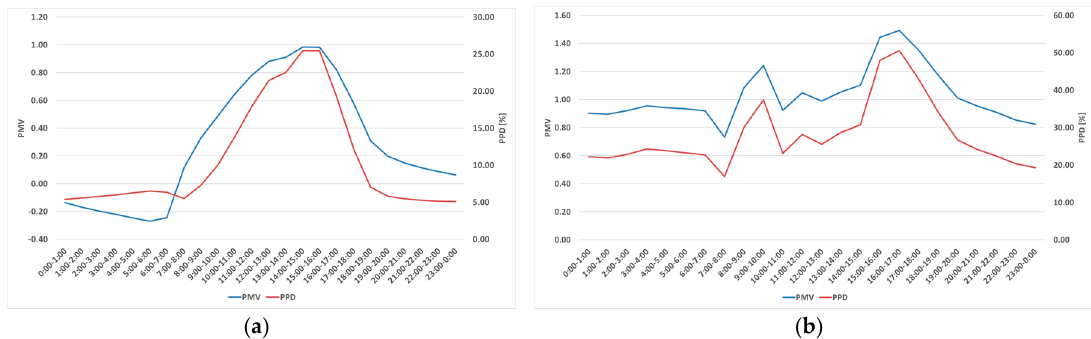
Figure 11. Variation of predicted mean vote (PMV) index in Building A during a typical day in: ( a ) winter (23 February 2016) and ( b ) summer (8 September 2016), along with the respective predicted percentage of dissatisfied (PPD) rates.